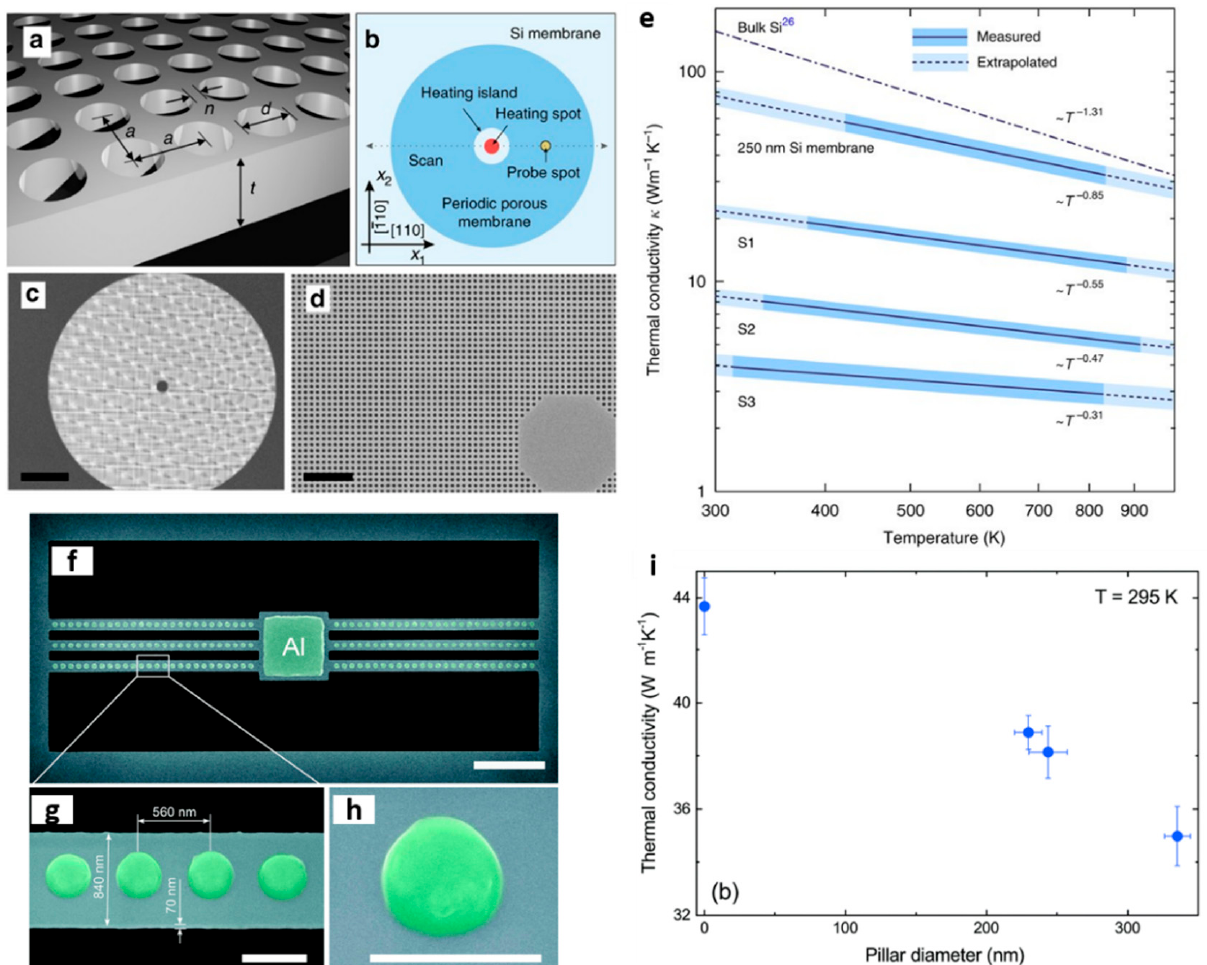
Figure 1. Phonon engineering in membrane-based structures. ( a ) Schematic of a hole-based PnC—square lattice of cylindrical holes in a 250 nm thick suspended membrane, where d is the hole diameter, a is the lattice parameter, and n is the neck size. ( b ) Schematic of a sample design showing relative laser heating and probing positions and ( c , d ) scanning electron microscope images of a PnC with a = 250 nm and d = 140 nm. Scale bars in ( c , d ) are 20 and 2 μ m, respectively. ( e ) Thermal conductivity of hole-based PnCs as a function of temperature and filling fraction S with S1 = 0.159, S2 = 0.246 and S3 = 0.332. ( f , g ) SEM images of a pillar-based PnC—Si nanobeam with one-dimensional arrays of pillars with a period of 560 nm and pillar base diameters of 229.5, 243.5 and 335 nm and ( h ) SEM image of a single nanopillar. Scale bars are ( f ) 5 µ m and ( g – h ) 500 nm. ( i ) Thermal conductivity of different nanobeams as a function of pillar diameter at 295 K. ( a – e ) reproduced with permission from [24]. Copyright Springer Nature, 2017. ( f – i ) Reproduced with permission from [28], Copyright Royal Society of Chemistry, 2017.